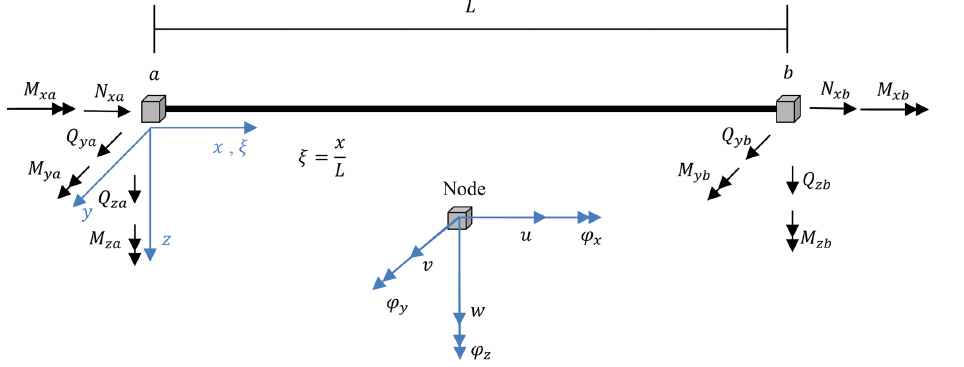
Figure 2. The finite beam element: internal forces and nodal DOFs.